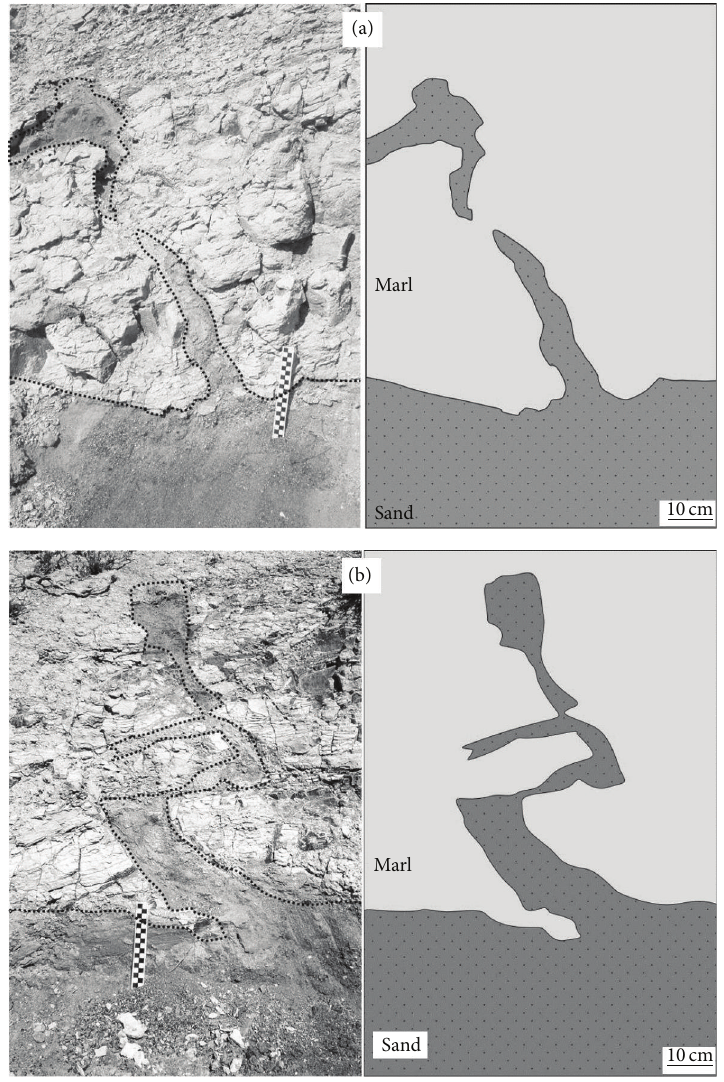
Figure 4: Clastic dikes that are seen in the study area. (a) In this figure coarse-grained sand clearly intrudes overlying layered marls (37.768 N, 29.152 E). (b) Sills and dikes of fine-grained sand in marls (37.768 N, 29.154 E).